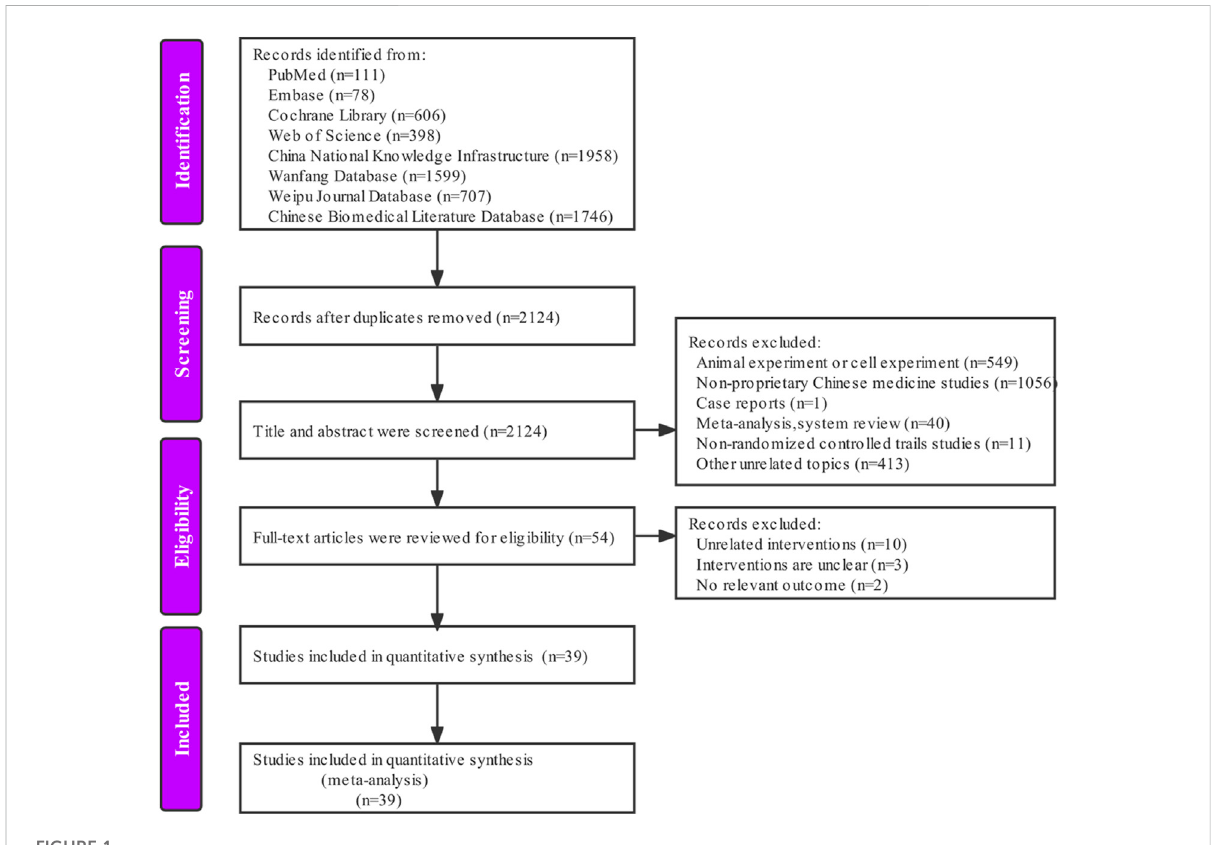
FIGURE 1 Study selection